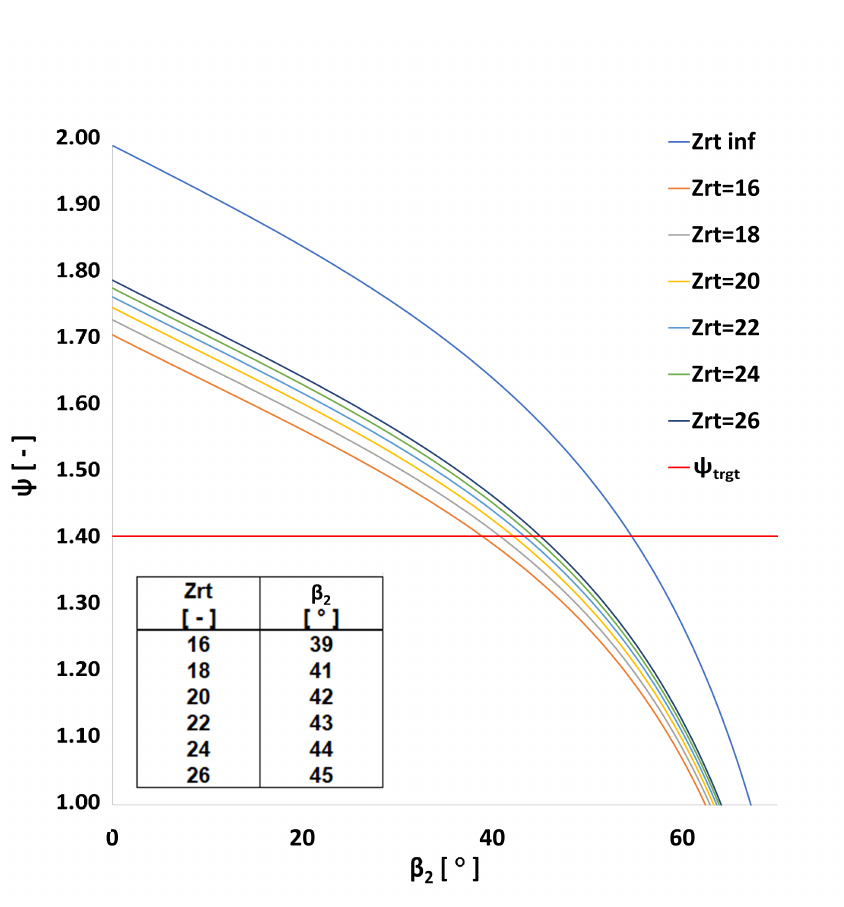
Figure 2. Load coefficient vs. backsweep angle, for a finite and infinite number of blades Z rt